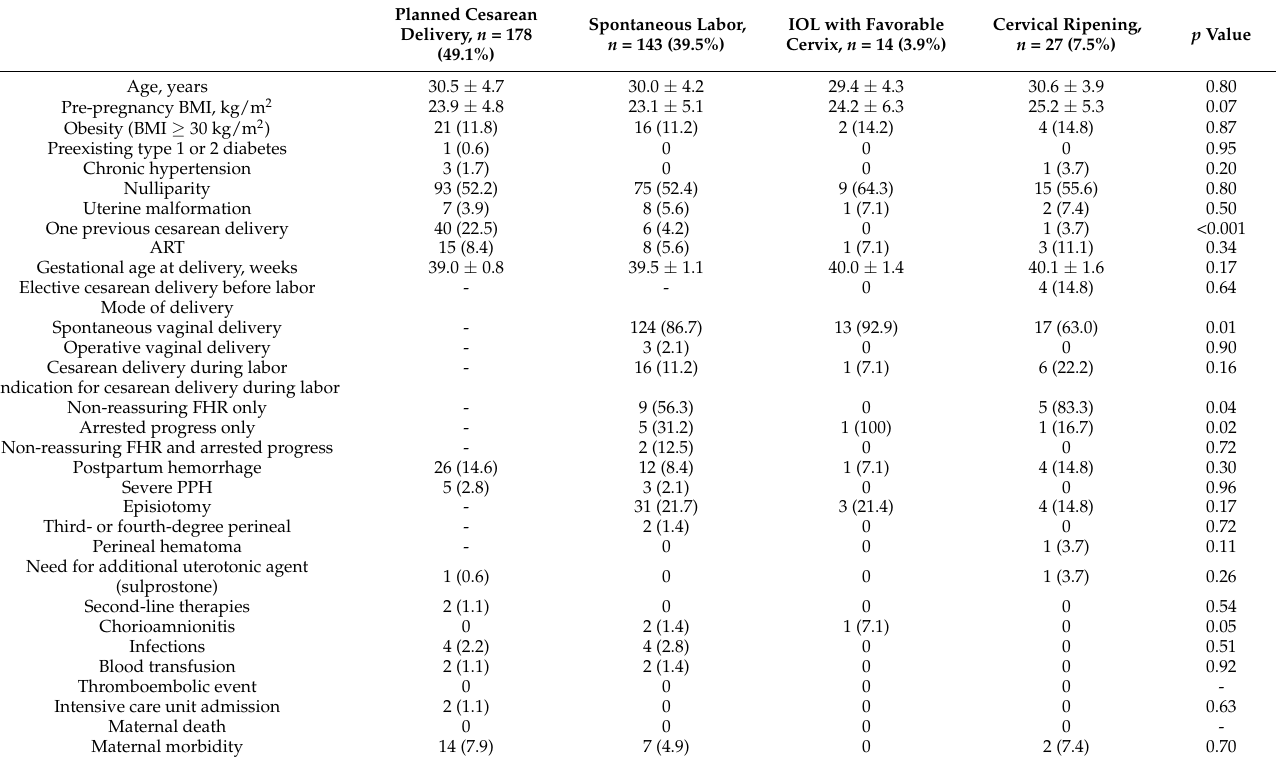
Table 1. Maternal and labor characteristics, and maternal outcomes according to the type of labor. Planned Cesarean Spontaneous Labor, IOL with Favorable Cervical Ripening, Delivery, n = 178 n = 143 (39.5%) n = 27 Cervix, n = 14 (3.9%) (49.1%)